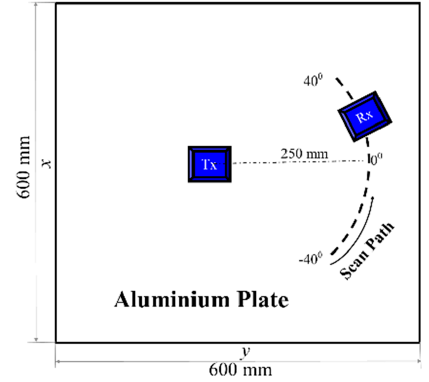
Figure 16. The scanning path of the receiver.